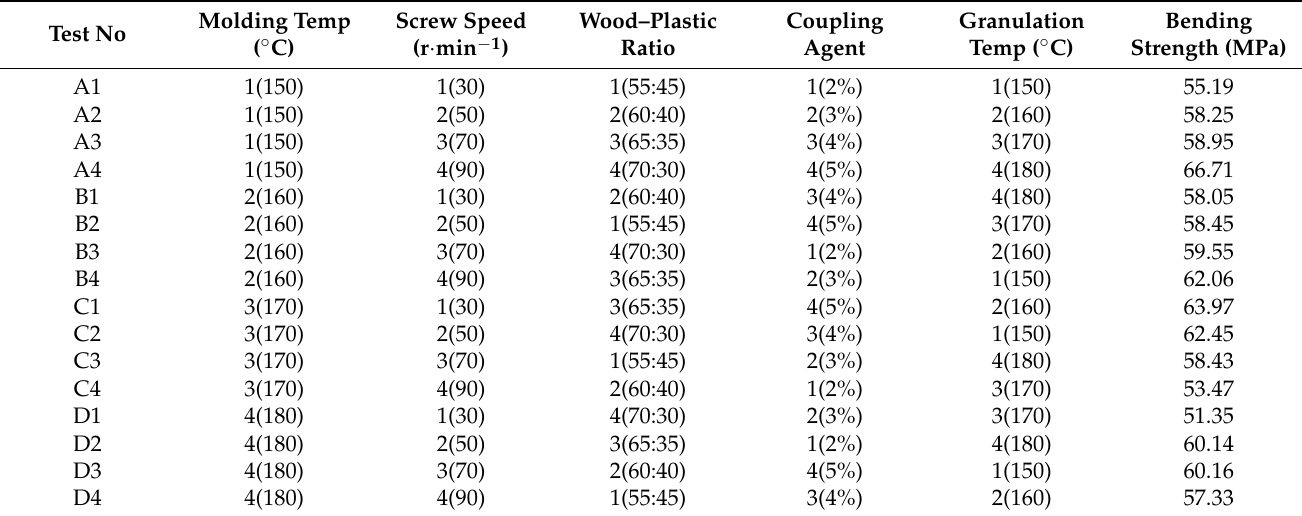
Table 1. Orthogonal test table for specimen preparation.